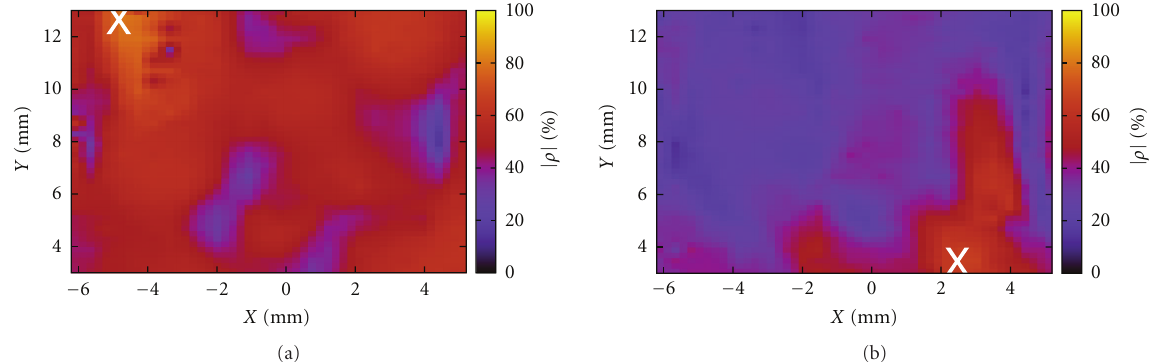
Figure 8: CEMA maps obtained knowing the activity of the MASK (a) and LR (b) registers. The white cross indicates the point of greatest ρ